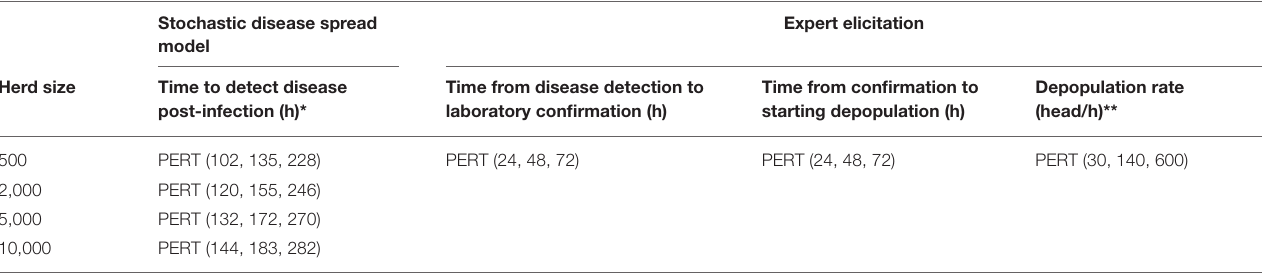
Expert elicitation